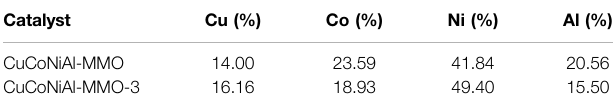
TABLE 3 | The concentration of Cu, Co, Ni, Al in CuCoNiAl-MMO and CuCoNiAl- MMO-3 catalysts.